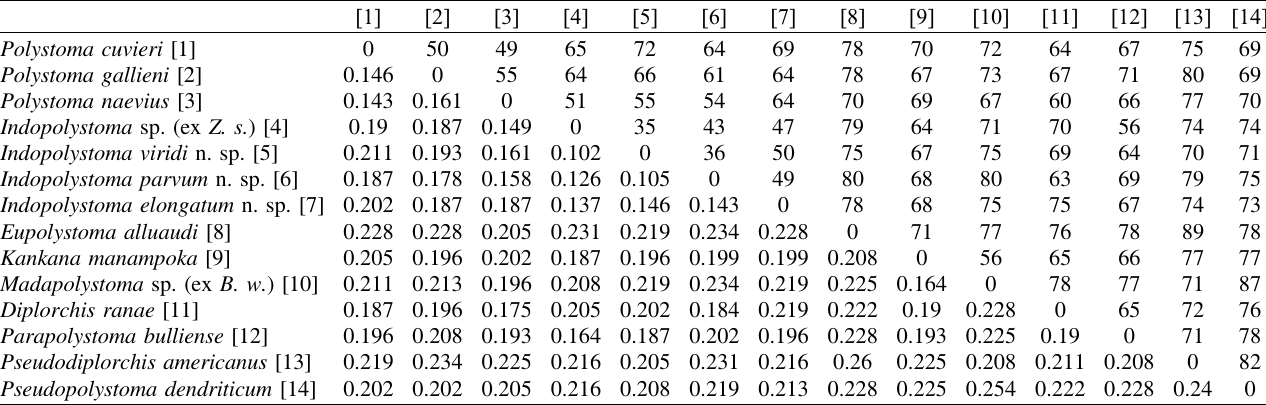
Table 2. Matrix of COI p -distances (lower left) and total differences (upper right) inferred from pairwise comparisons in MEGA7. B. w. refers to B. wittei and Z. s. to Z. smaragdinus . See also Table 1 for other host species.